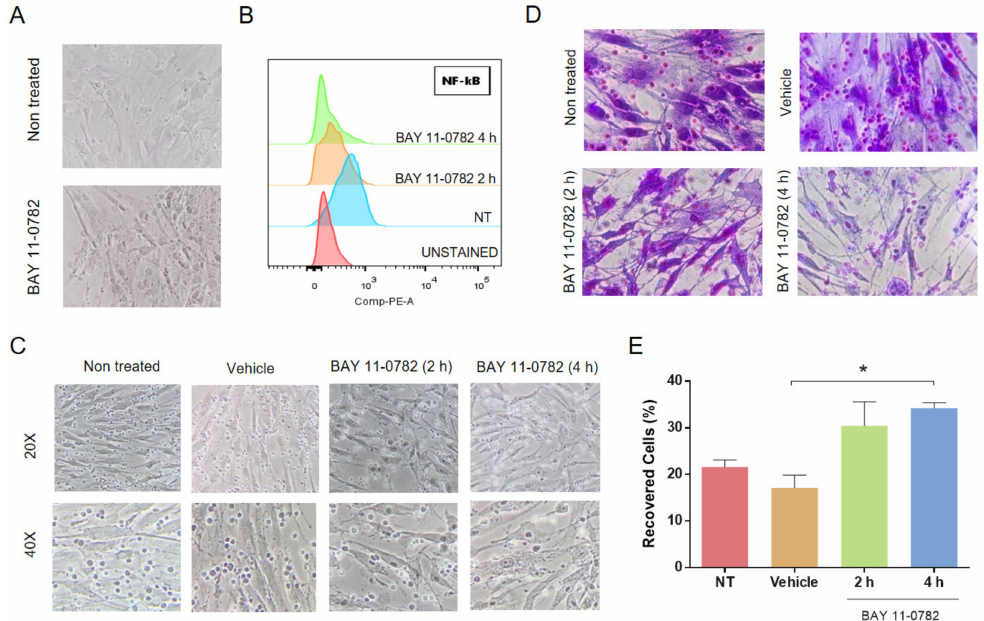
Figure 3. NF- κ B inhibition in MSC alters the B-ALL cells’ adhesion. ( A ) Morphological changes in MSC after 4 h of treatment with 10 µ M of BAY inhibitor. Representative microphotographs are